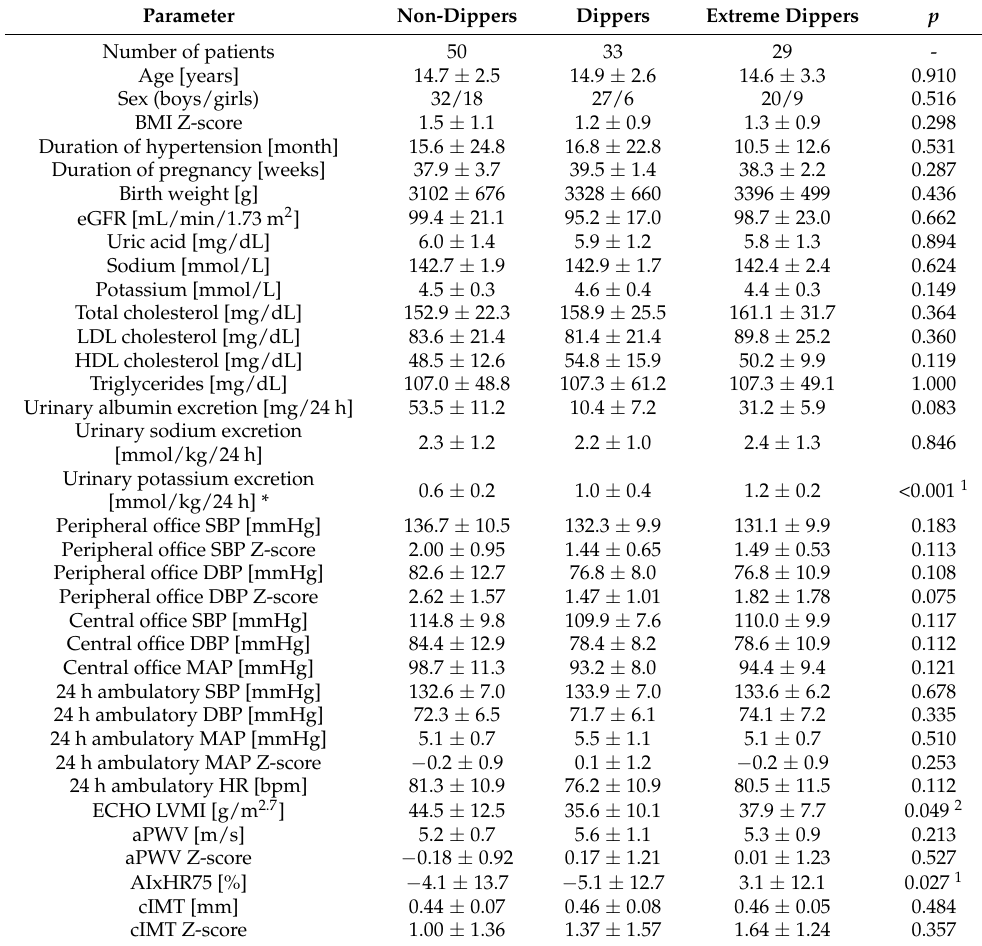
Table 7. Differences in analyzed parameters between dippers and non-dippers in the studied children (mean ± SD).